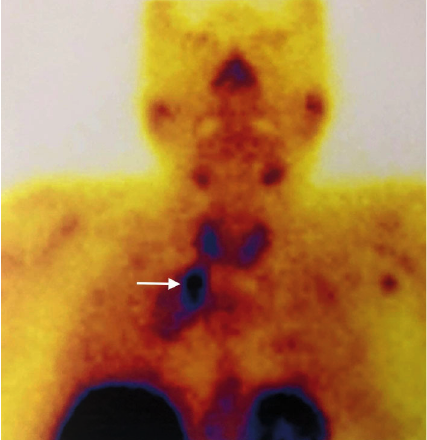
Figure 1: Radionuclide parathyroid scintigraphy with 99mTc- sestamibi scan demonstrates focal abnormal persistent uptake inferior to the right thyroid lobe and extending into the mediastinum